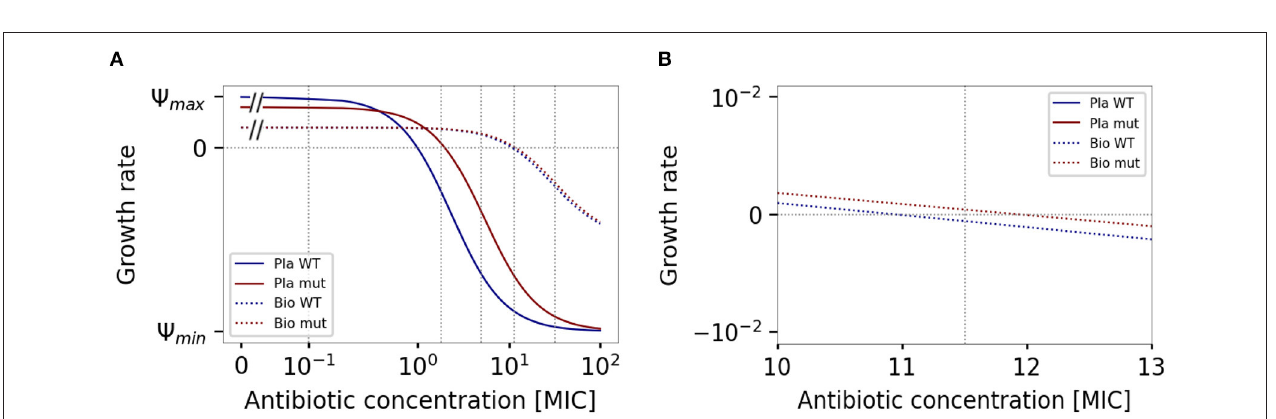
FIGURE 4 | Pharmacodynamic curves of the wild type (blue) and the mutant (red) in both biofilm (dotted lines) and plankton (solid lines). Vertical dotted lines represent the initial drug concentrations used for the simulations. (A) Sampled concentration range on a log scale. (B) Detail of the MSW in biofilm, on a linear